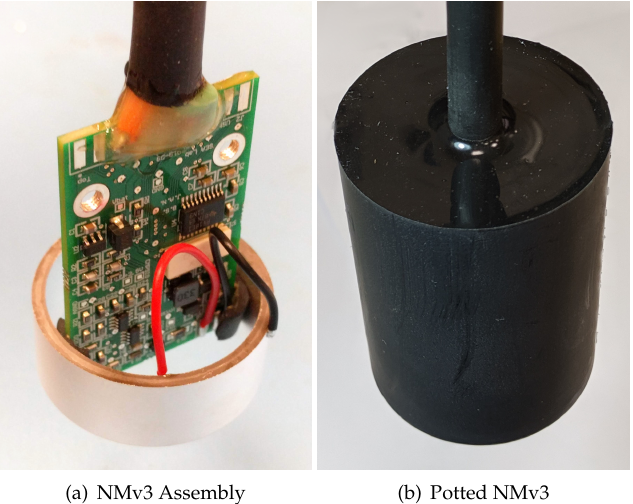
Figure 8. Photo of ( a ) NMv3 Assembly, and ( b ) Potted NMv3. Crystal outer diameter: 34mm. Potted NMv3 length: 60mm, diameter: